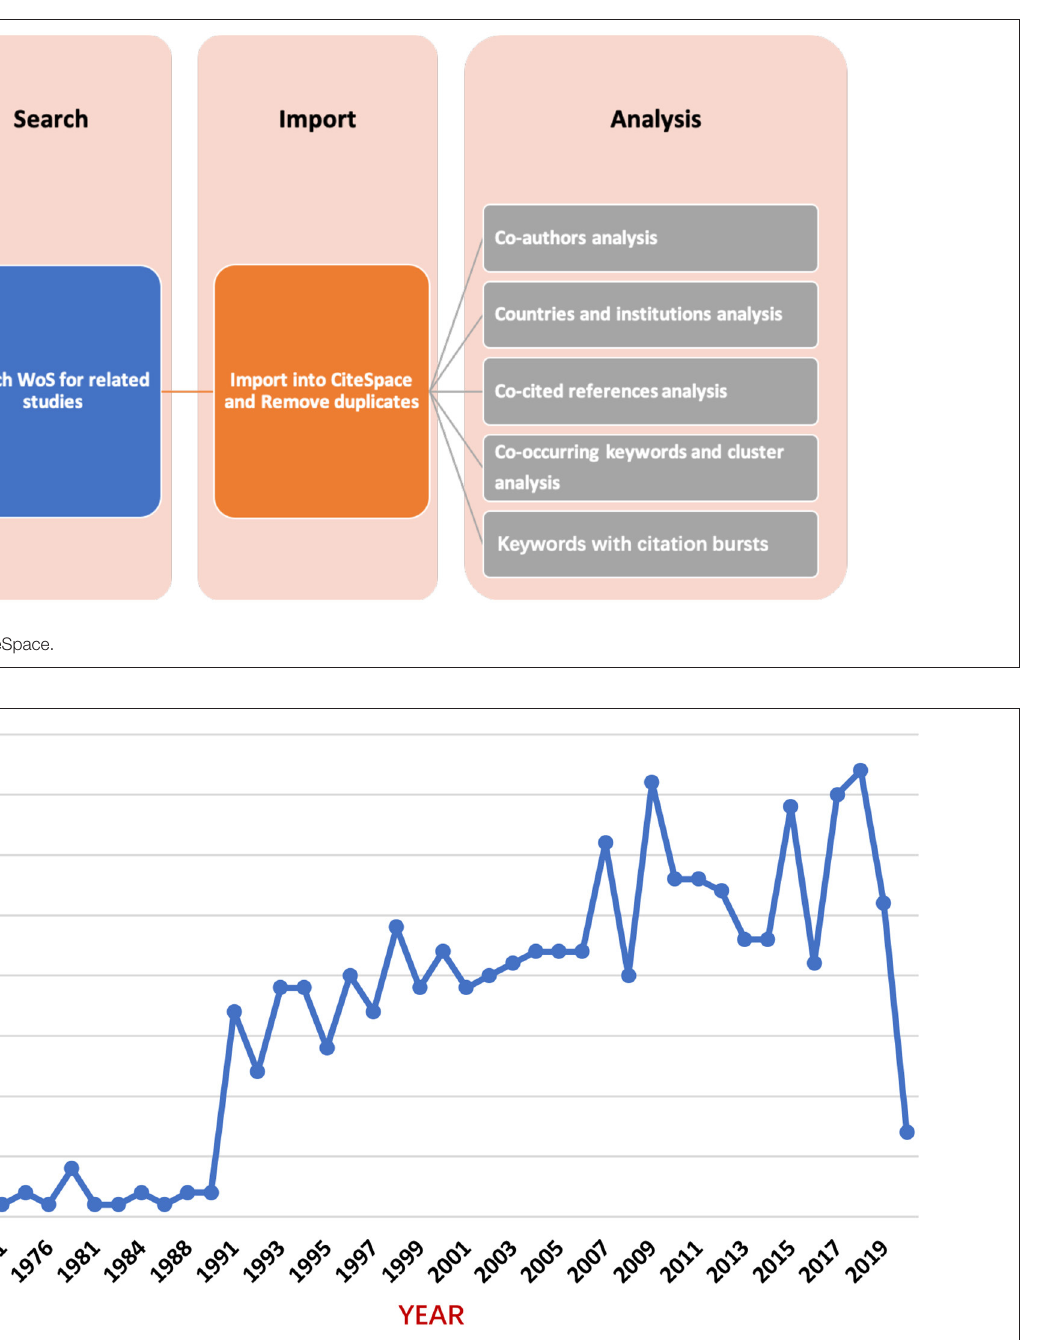
FIGURE 2 | Annual trend chart of